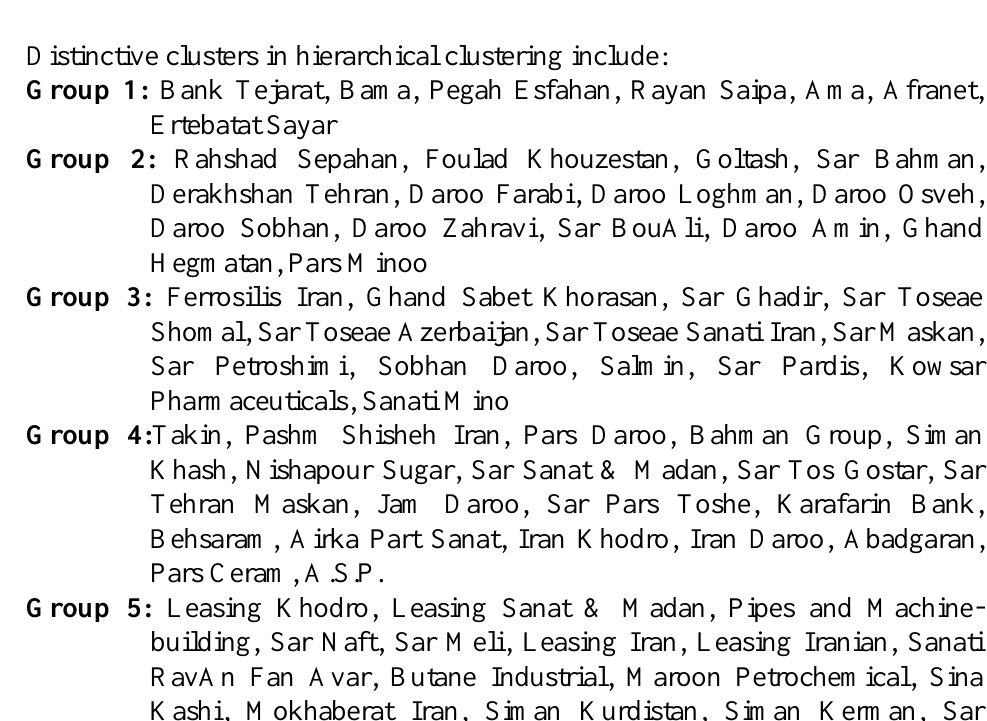
Figure 2. Hierarchical clustering based on behavioral